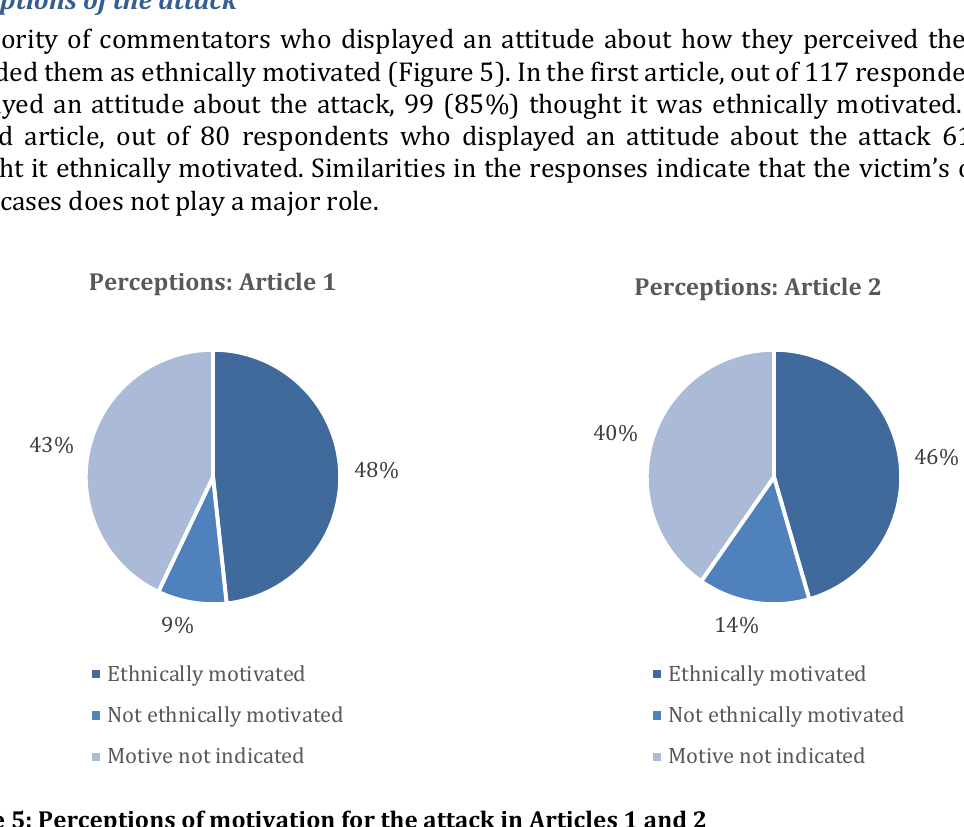
An example of commentary which viewed the incident as an ethnically motivated